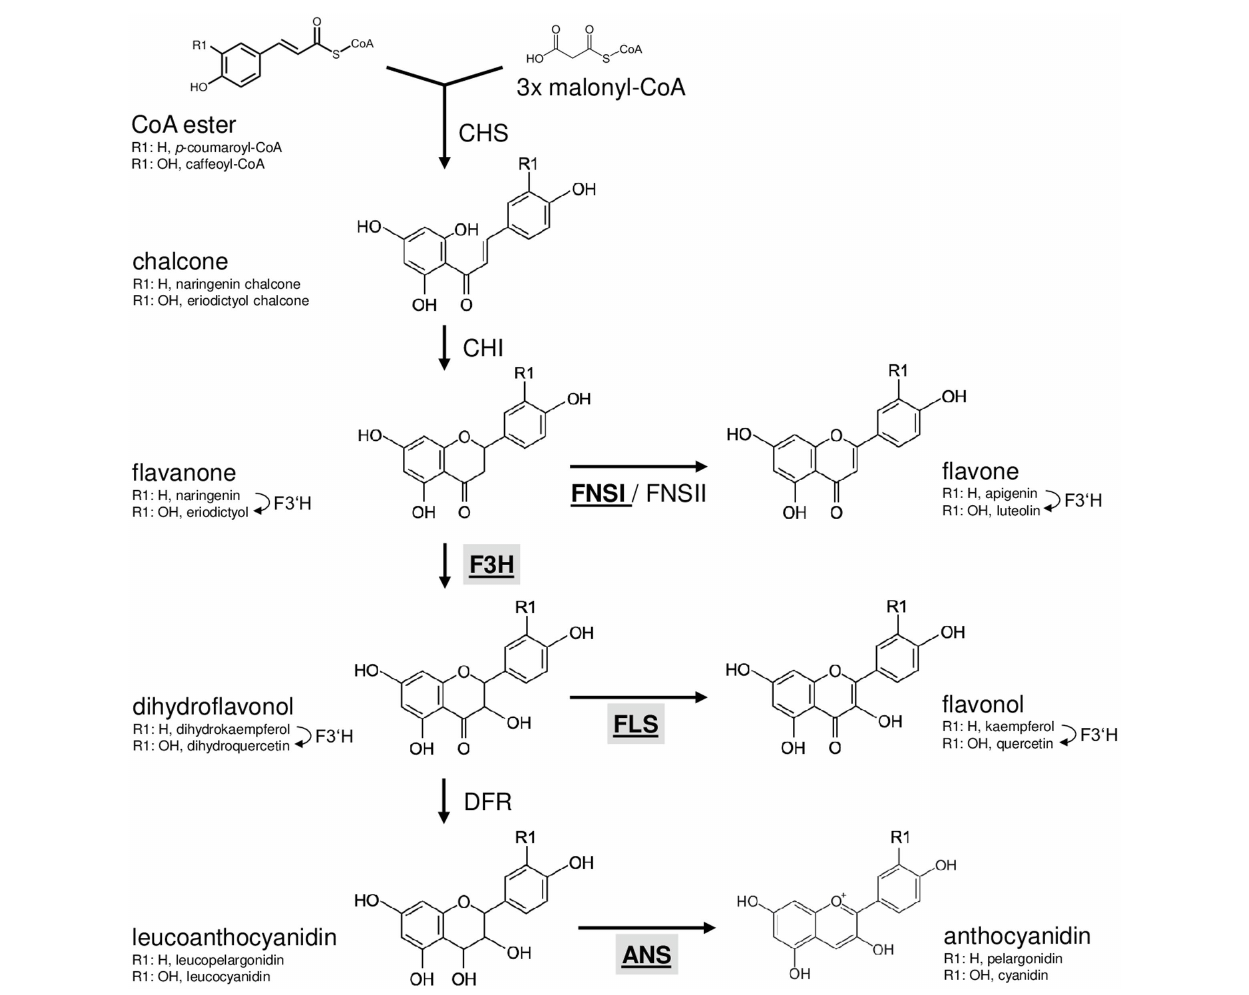
FIGURE 1 | Schematic, simplified illustration of the core flavonoid aglycon biosynthesis pathway in plants. Chalcone synthase, the first committed enzyme in flavonoid biosynthesis, connects a CoA ester and malonyl CoA, forming a chalcone. Chalcone isomerase introduces the heterocyclic ring. The resulting flavanone is converted to dihydroflavonol by flavanone 3-hydroxylase (F3H) or to flavones by flavone synthase (FNSI or FNSII). Dihydroflavonols are converted to flavonols by flavonol synthase (FLS). Alternatively, dihydroflavonol 4-reductase can reduce dihydroflavonols to the corresponding leucoanthocyanidin, which is converted to anthocyanidin by the activity of anthocyanidin synthase (ANS). Flavonoid 3 ' hydroxylase hydroxylates 3 ' position of the B-ring using different flavonoid substrates. 2-oxoglutarate-dependant oxygenases are given in bold underlined. Enzymes in the focus of this work are highlighted by grey